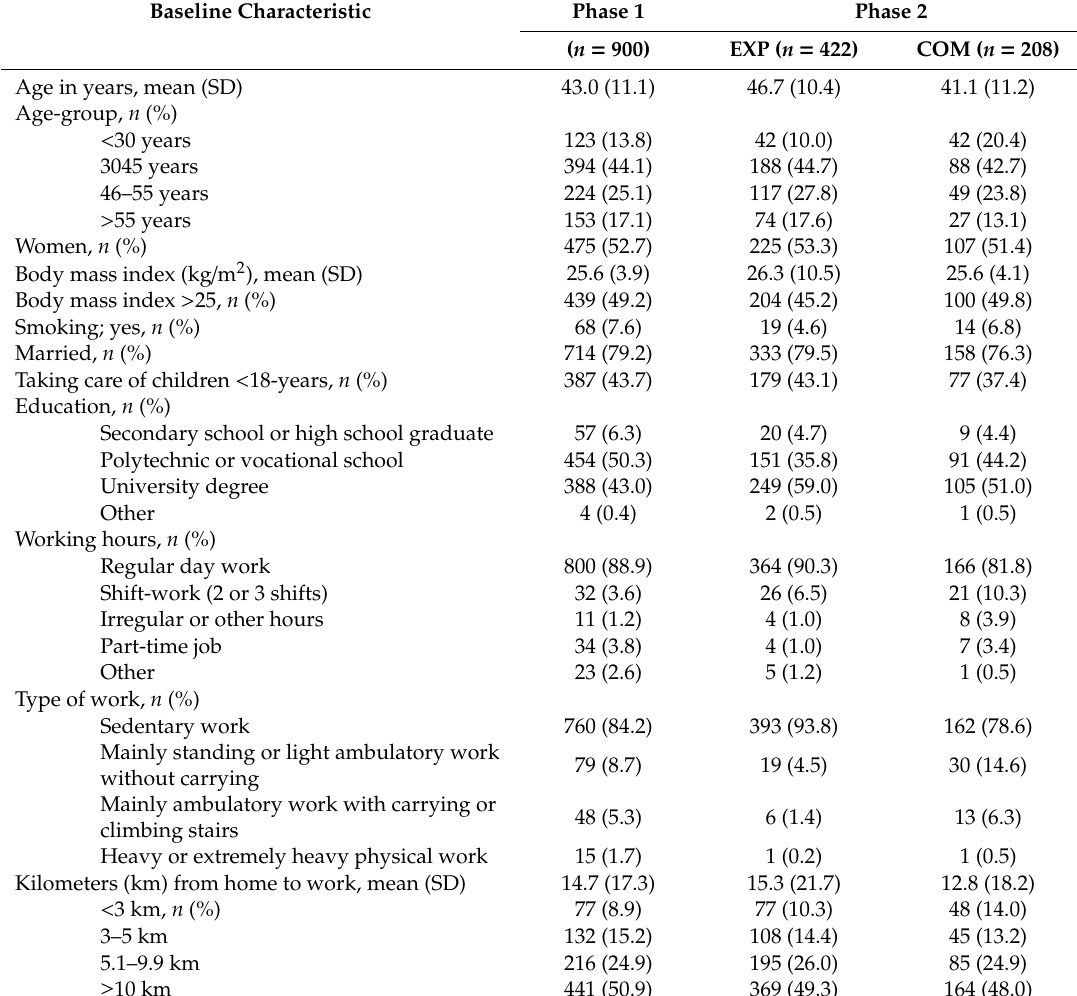
Table 2. Baseline characteristics of the participants in Phase 1 and Phase 2. EXP: experimental group; COM: comparison